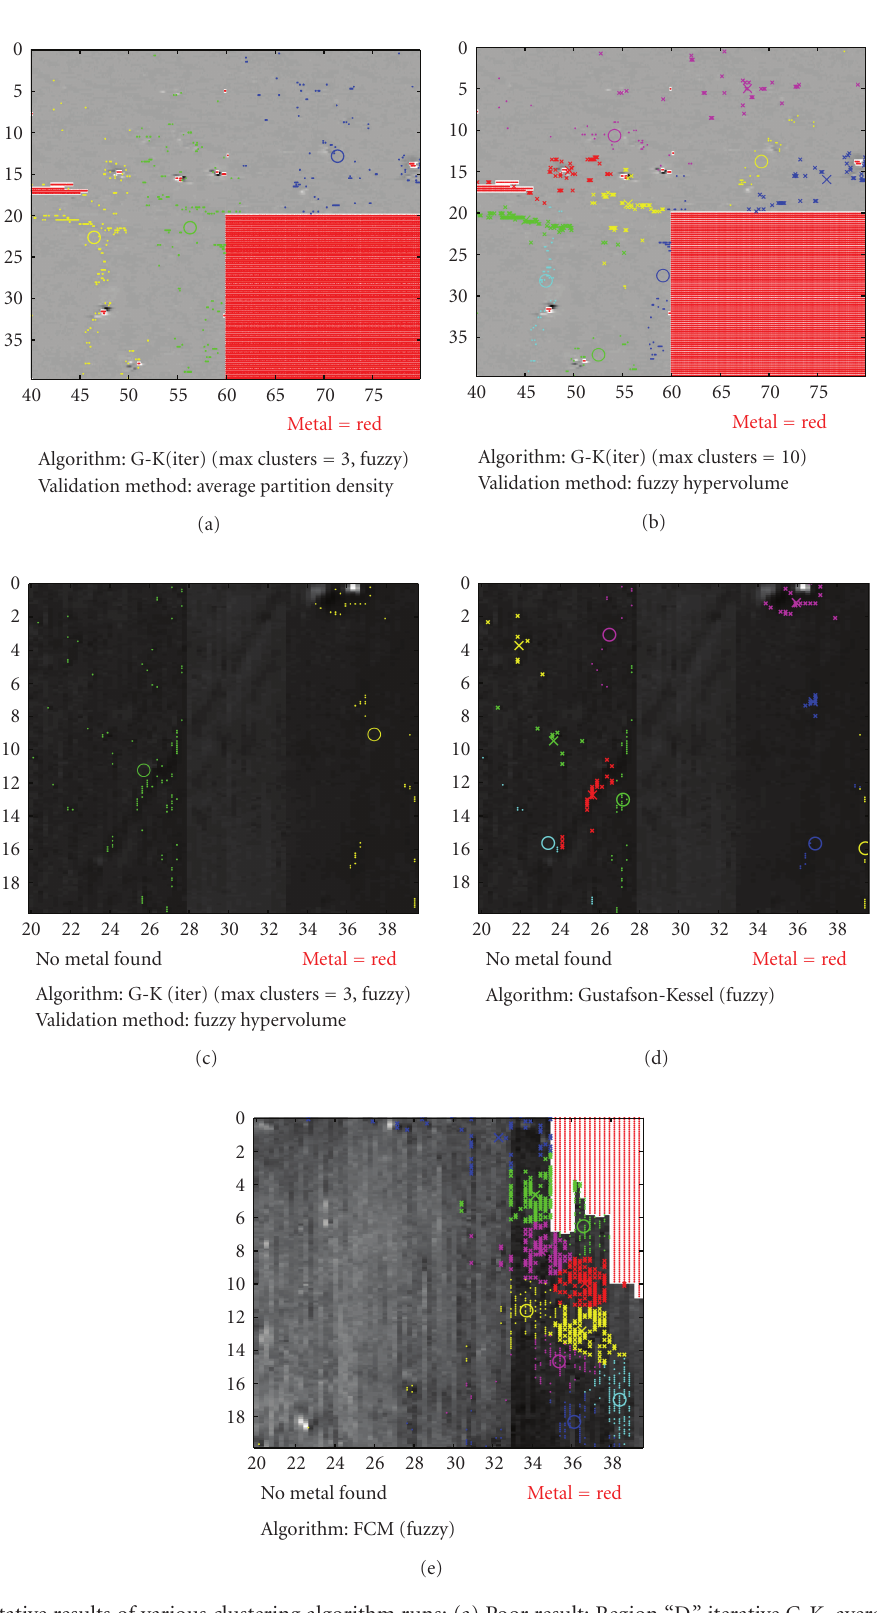
Figure 11: Representative results of various clustering algorithm runs: (a) Poor result: Region “D,” iterative G-K, average partition density performance measure, maximum clusters = 3; (b) Good result: Region “D,” iterative G-K, fuzzy hypervolume performance measure, maximum clusters = 10; (c) Poor result: Region “C,” iterative G-K, fuzzy hypervolume performance measure, maximum clusters = 3; (d) Good result: Region “C,” G-K, max clusters = 10; (e) Poor result: Region “A,” FCM, max clusters =